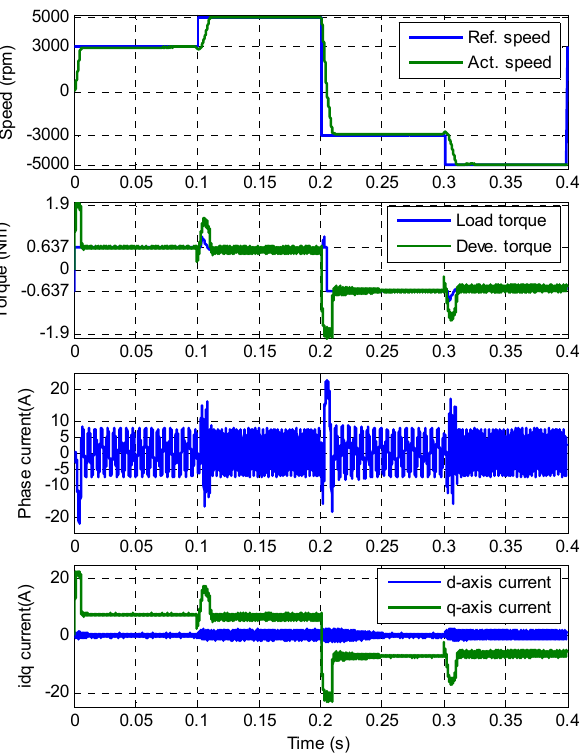
Figure 6. The dynamic performance of the PMSM side without modulated FCS-MPC. From top to bottom: reference and motor speeds, load and developed torques, phase current, and dq currents.